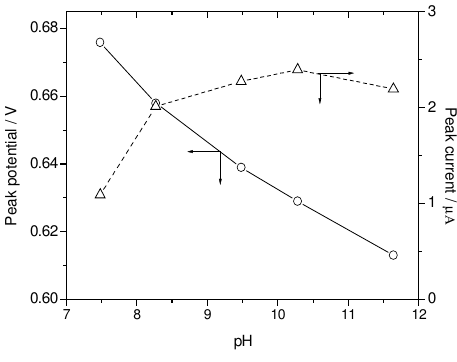
Figure 3. Variation of peak current and peak potential with solution pH (with DEC SAM/Au). Prochloperazine concentration: 10 (cid:1) M, other conditions as in Figure